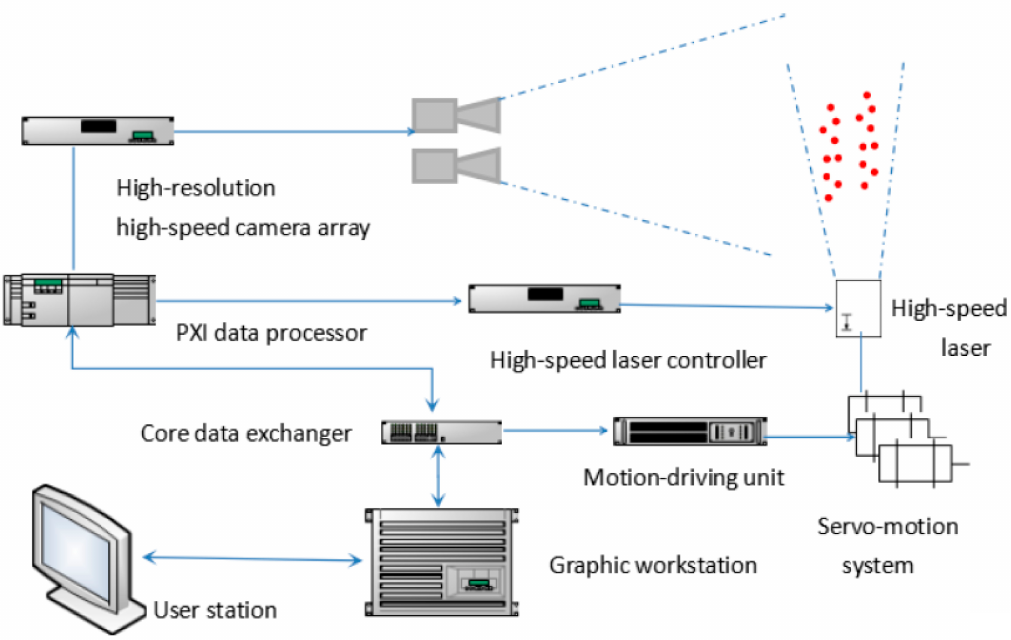
Figure 3. Diagram of the particle image velocimetry (PIV)